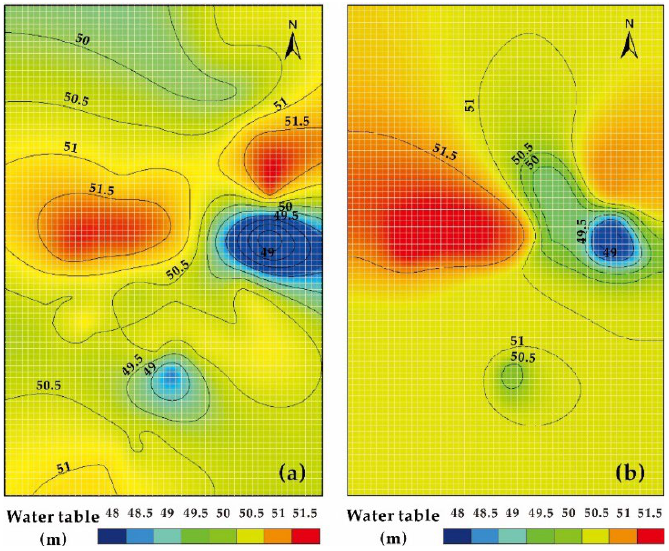
Figure 6. Water table distribution comparison: ( a ) Interpolated water table; ( b ) simulated water table.